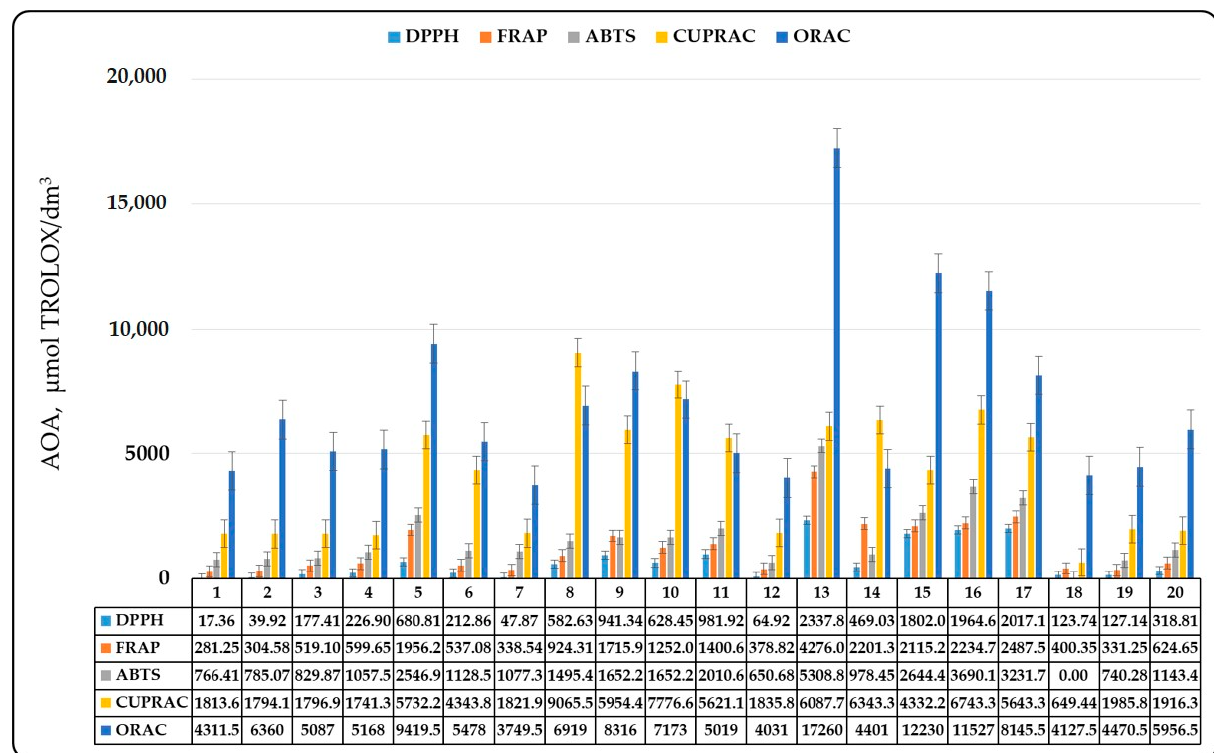
Figure 6. Wort antioxidant activity. 1—Pilsen; 2—Pale ale; 3—Vienna malt; 4—Munich; 5—Melanoidine; 6—Munich dark; 7—Wheat; 8—Red X; 9—Caramel amber; 10—Caramel hell; 11—Black; 12—Caramel pils; 13—Special X; 14—Special Wheat; 15—Caramel Munich I; 16—Caramel Munich II; 17—Chocolate; 18—Rye; 19—Acidulated; 20—Smoked malt.